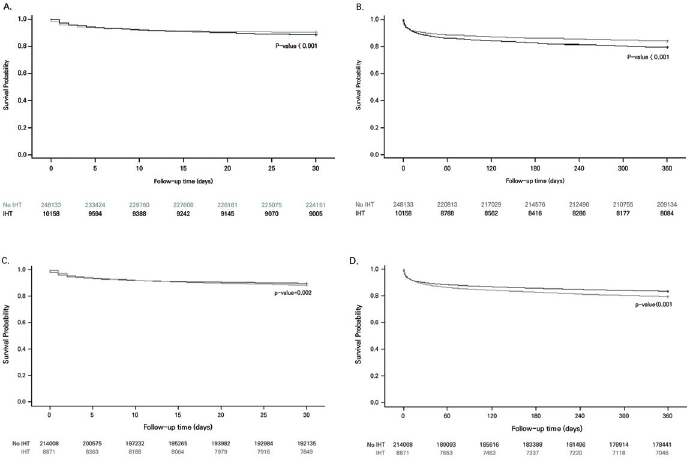
Fig 2. Survival curve of the 30-day and 1-year mortality in acute myocardial infarction patients grouped by inter- hospital transfer status before and after the standardized inverse probability of treatment weighting. A: Survival curve of the 30-day mortality, B: Survival curve of the 1-year mortality, C: Adjusted survival curve of the 30-day mortality, D: Adjusted survival curve of the 1-year mortality. Abbreviations: IHT, Inter-hospital